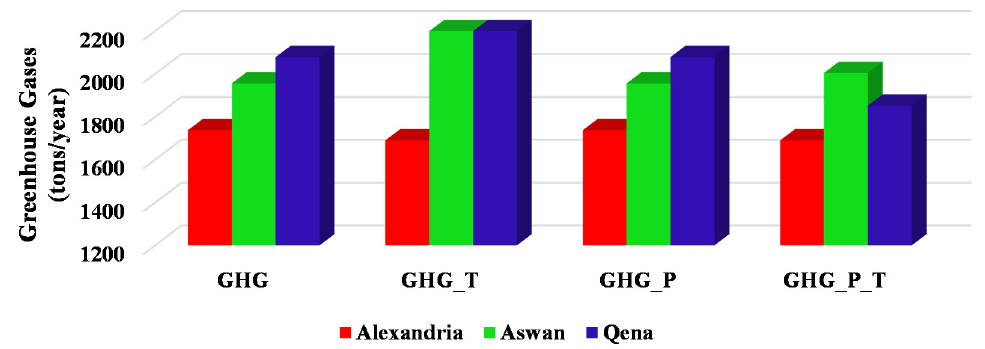
Figure 14. The different amounts of GHG emitted from a wind/diesel/battery system in Alexandria, Aswan and Qena.